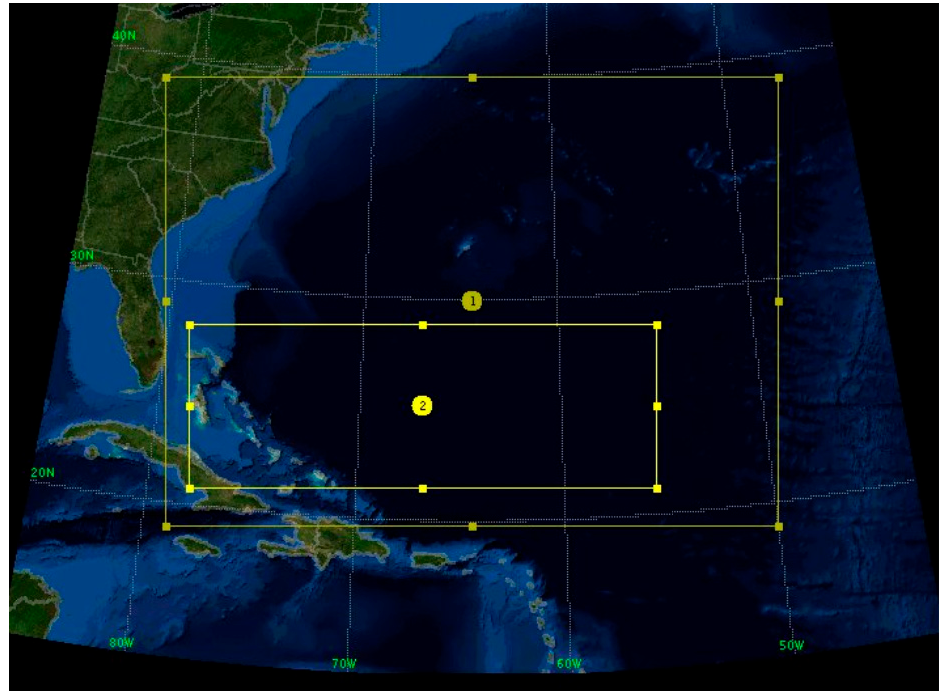
Figure 5. Research domain considered in this study: (1) larger domain centered at (30N, − 65W) at 15 km horizontal resolution; and (2) smaller domain at 5 km horizontal resolution covering the path of hurricane Matthew between 28 September and 6 October 2016.